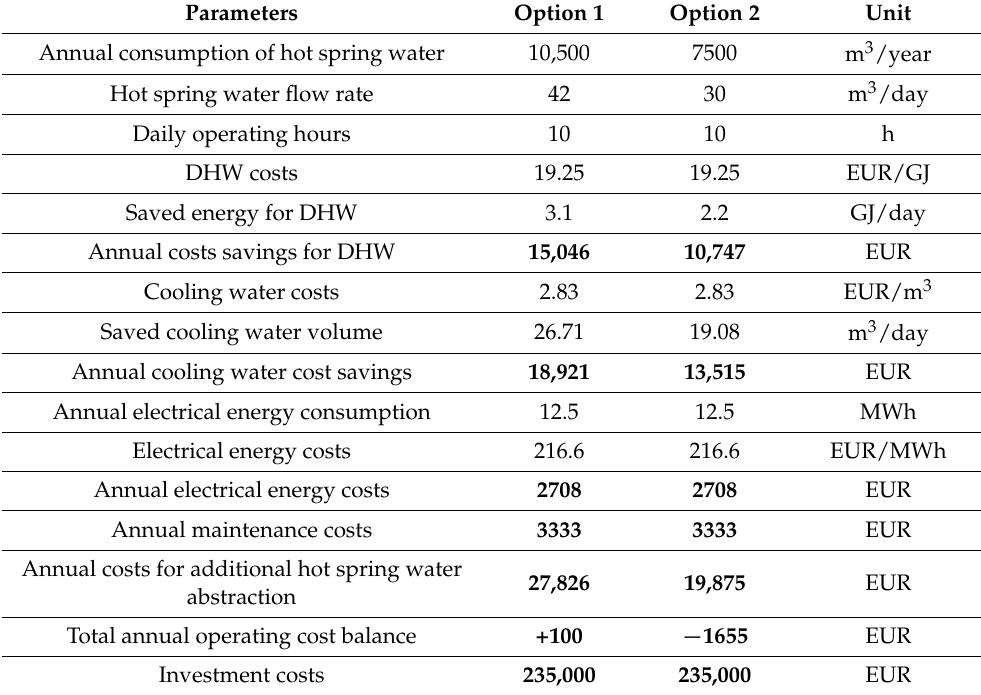
Table 7. Technical–economic assessment of the cooling